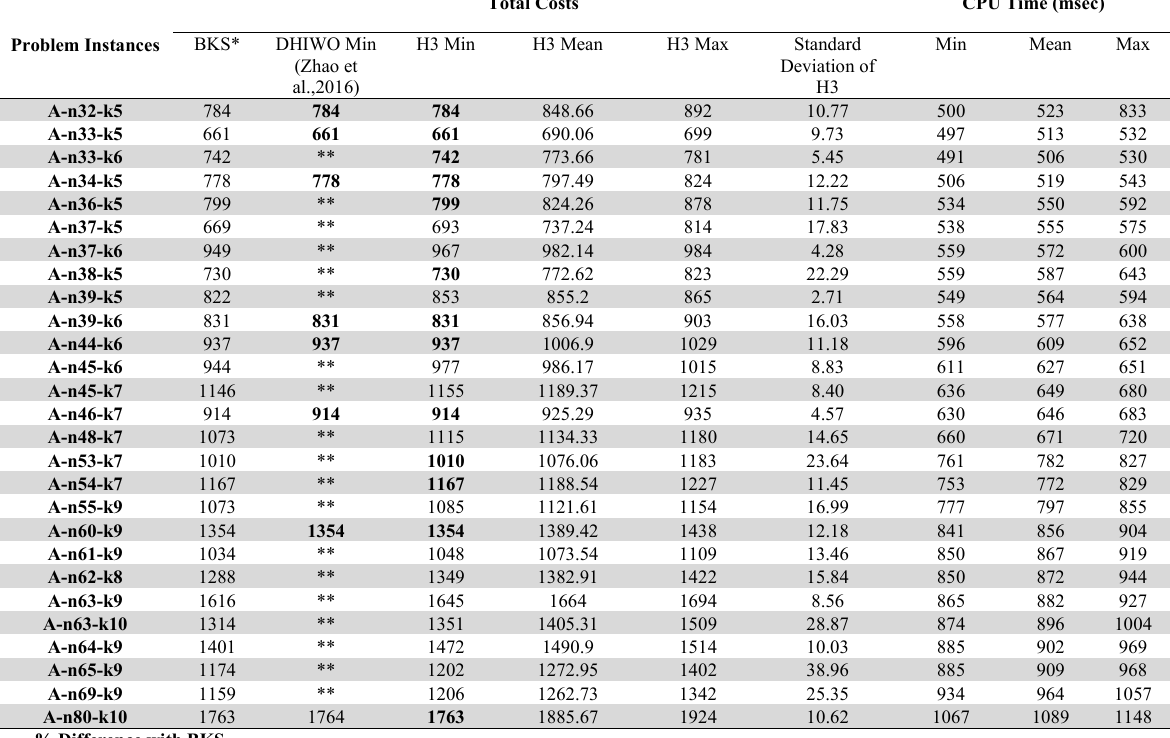
Table 6 Comparison of the results with previous works for problem instances A Problem Instances